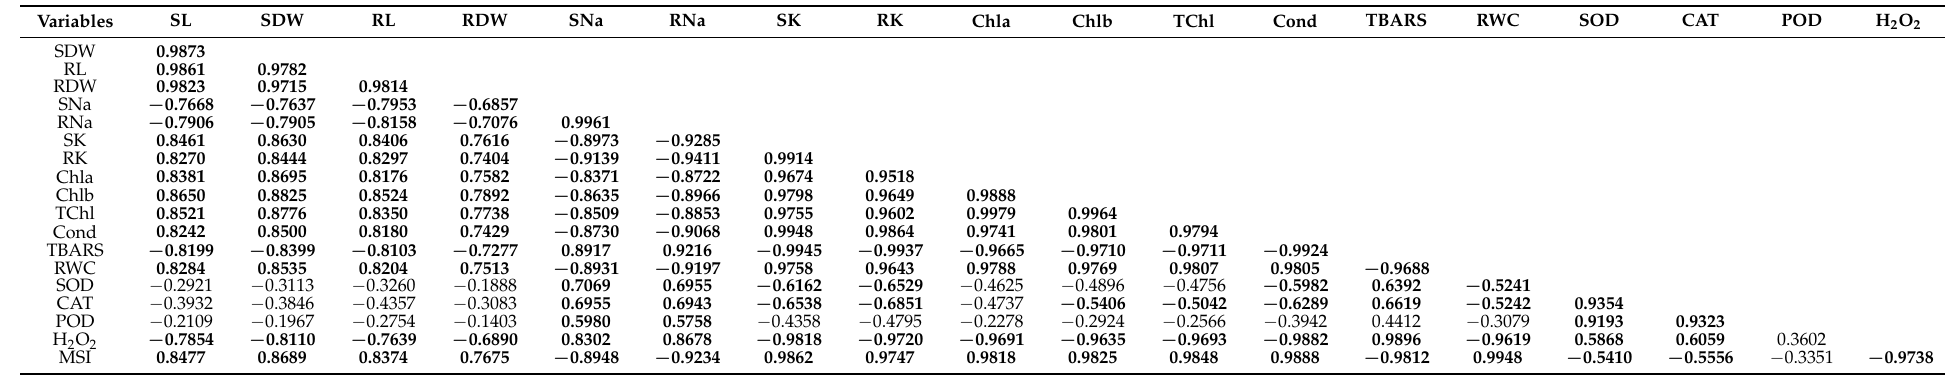
Table 3. Pearson’s correlation matrix of response variables of quinoa genotypes grown under salinity, drought, and heat stress. Values in bold indicate a significant correlation at alpha =